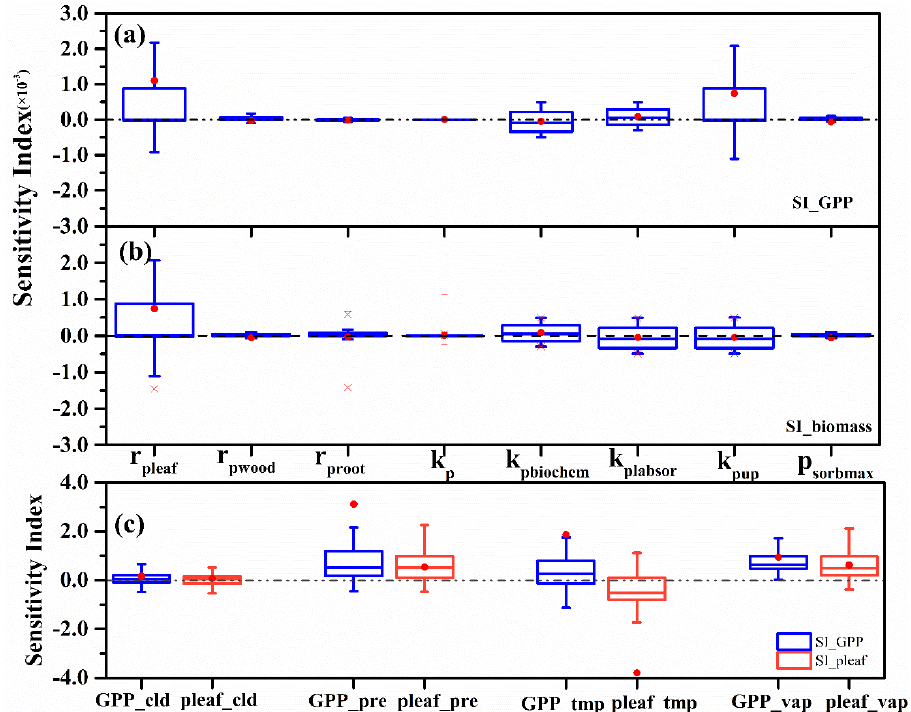
Figure 2. Sensitivity of ( a ) GPP and ( b ) biomass to variation in six key parameters and ( c ) four main meteorological factors. Red points represent mean values of the sensitivity index, and the dotted line describes where y = 0. In panel ( a , b ), rpeaf, rpwood, and rproot are phosphorus resorption coefficients of leaf, wood and root, respectively; kp, an empirical parameter for phosphorus limitation on net ecosystem productivity (NPP); kpbiochem, an empirical constant for biochemical phos- phorus mineralization; kplabsor, an empirical parameter for describing the equilibrium between labile and reabsorbed phosphorus; kpup, an empirical parameter relating plant phosphorus uptake rate to labile pool size in the soil; and psorbmax, the maximum amount of absorbed phosphorus. In panel ( c ), the sensitivity of GPP (blue boxes) and amount of leaf phosphorus (red boxes) to vari- ations in the indicated variables are shown.